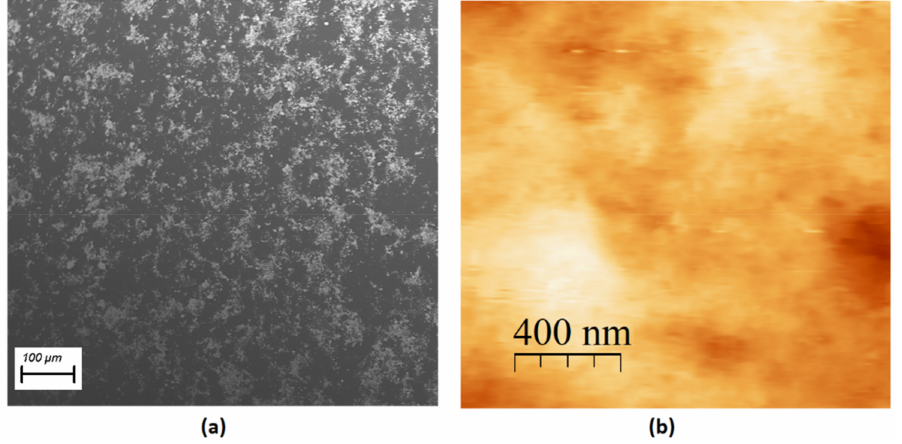
Figure 5. ( a ) SEM and ( b ) AFM of CuBi 2 O 4 NPs in